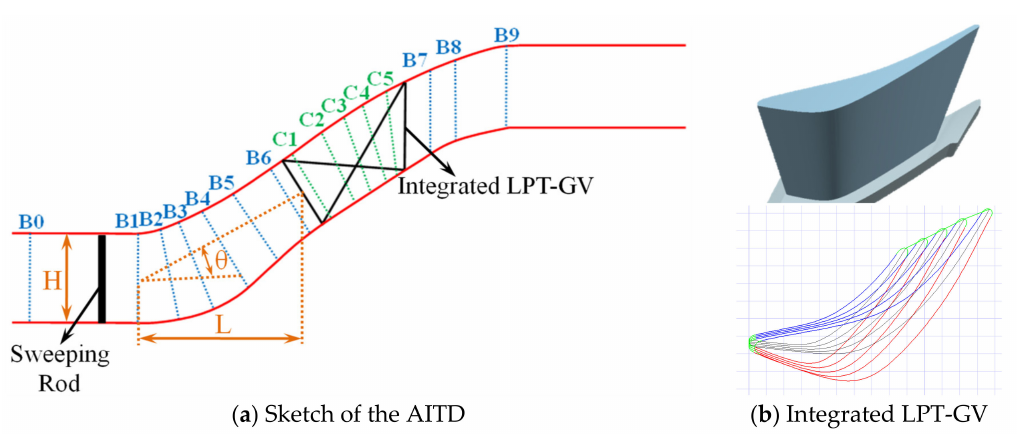
Figure 2. Cross section of the integrated AITD and measurement locations.